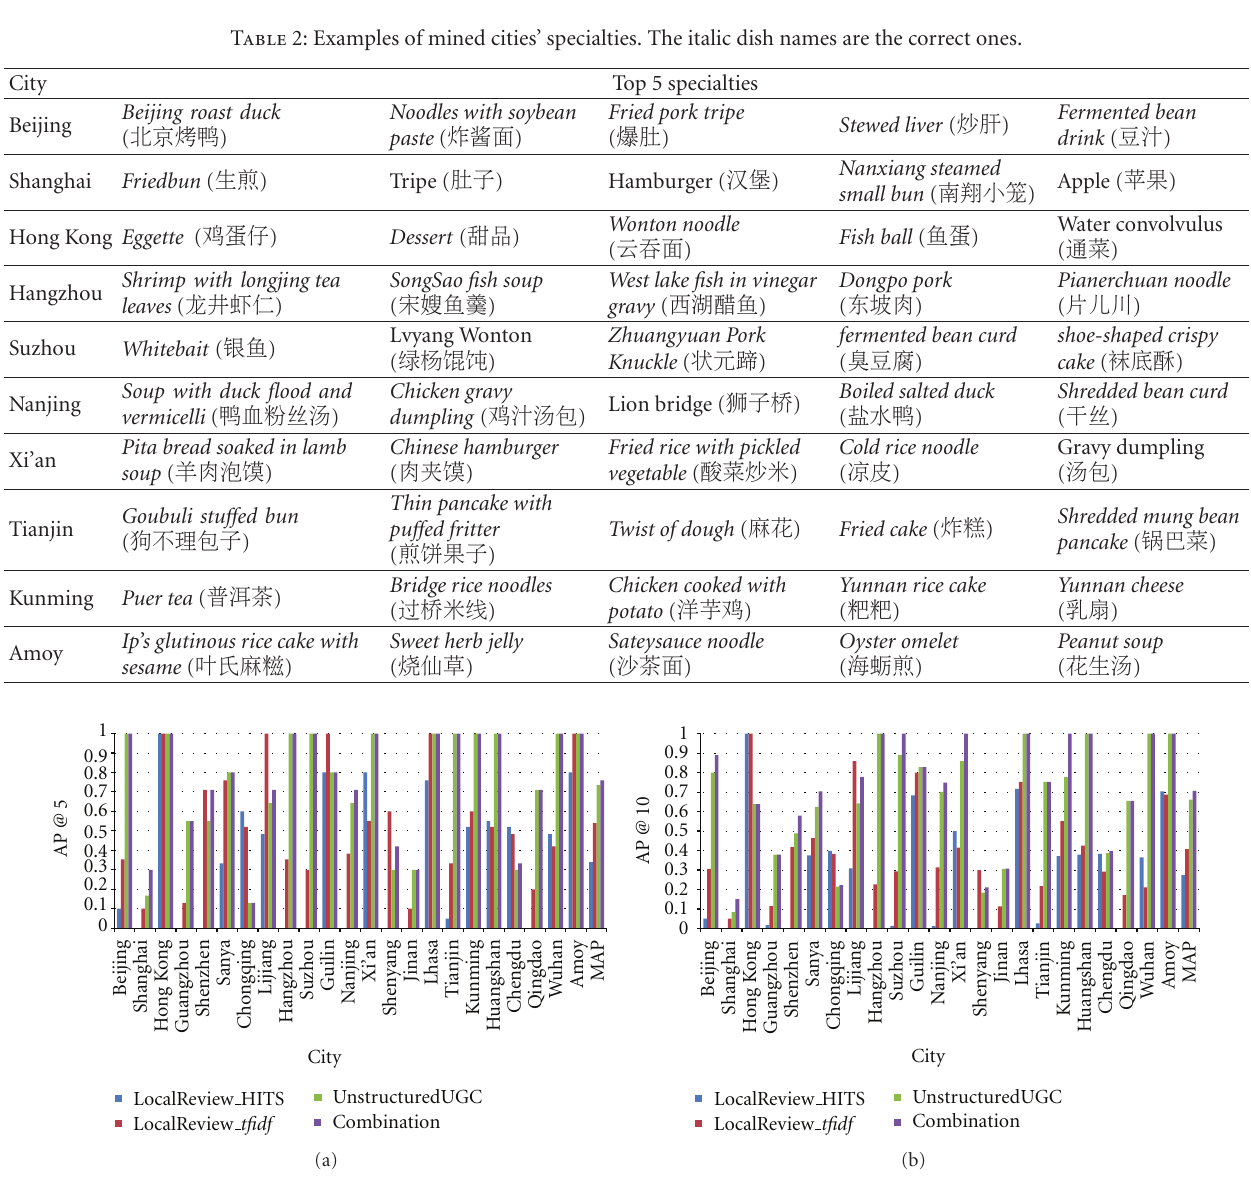
Figure 8: Average precision of top cities.